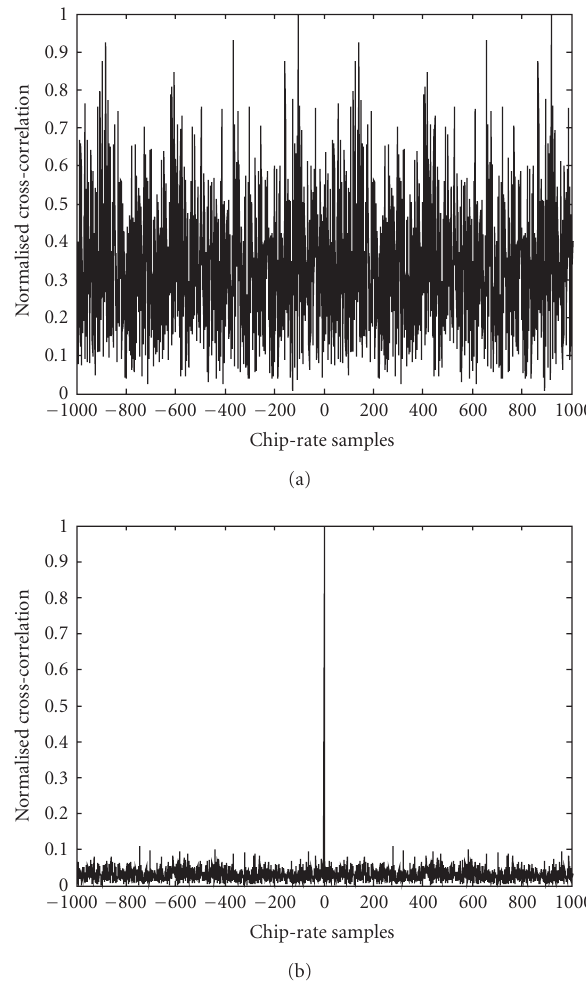
Figure 3: (a) Normalized cross-correlation before jammer removal. (b) Normalized cross-correlation after jammer